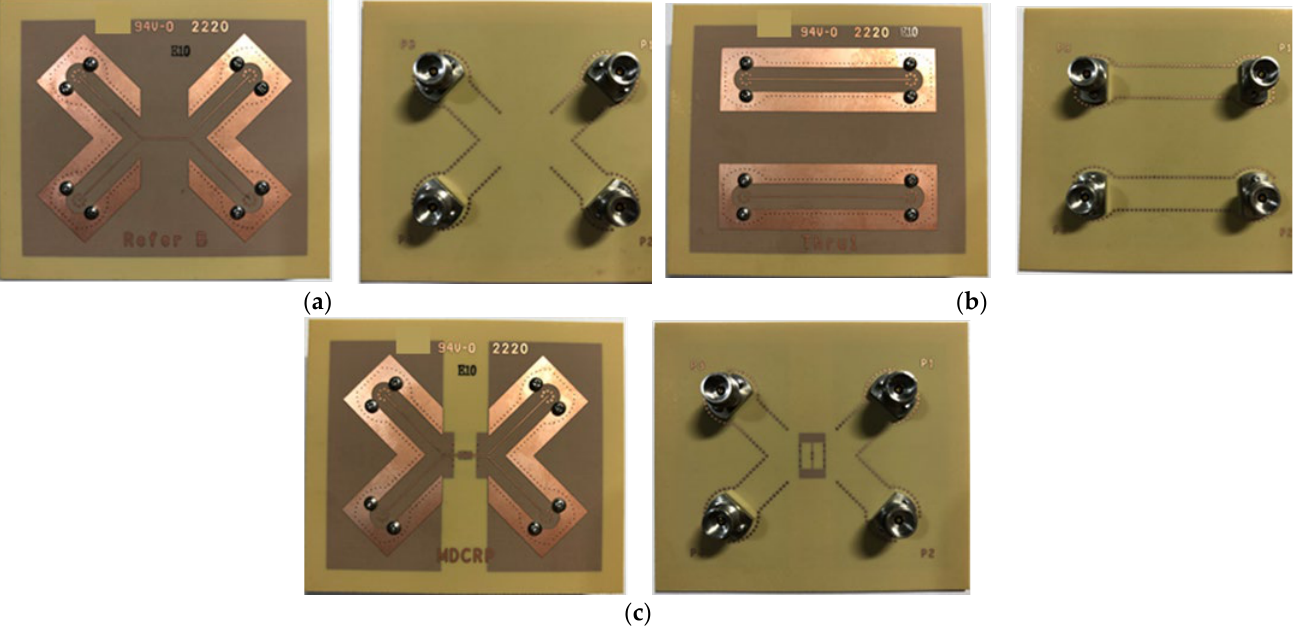
Figure 7. Photos of the measured PCB structure. ( a ) The reference boards. ( b ) The 2× through the board. ( c ) The MDCRP structure filter board.